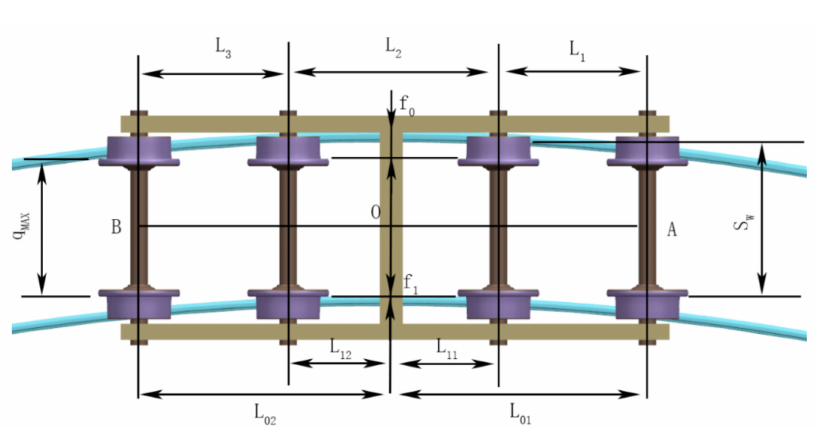
Figure 4. Schematic of the wedge-shaped inscribing